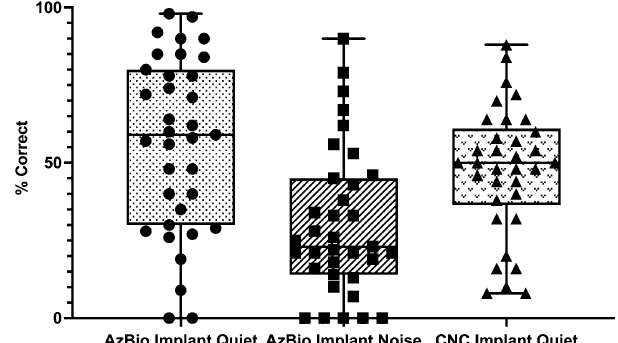
Figure 1. Box plots of performance measures showing all data points of 35 patients at 3 months across AzBio in Quiet, AzBio in Background Noise, and CNC in Quiet. All measurements were made with the CI-only condition. There was substantial variability across all speech recognition measures among CI